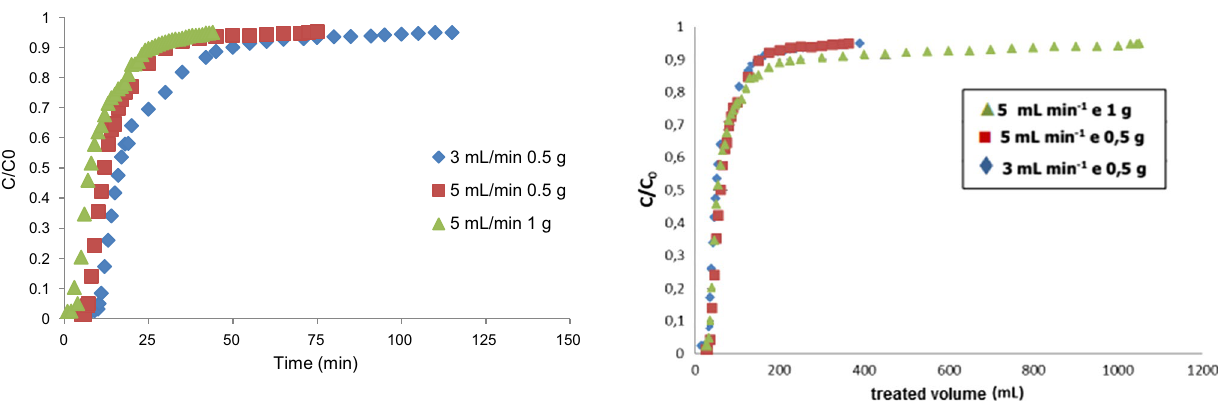
Fig. 8 Rupture curves in terms of volume